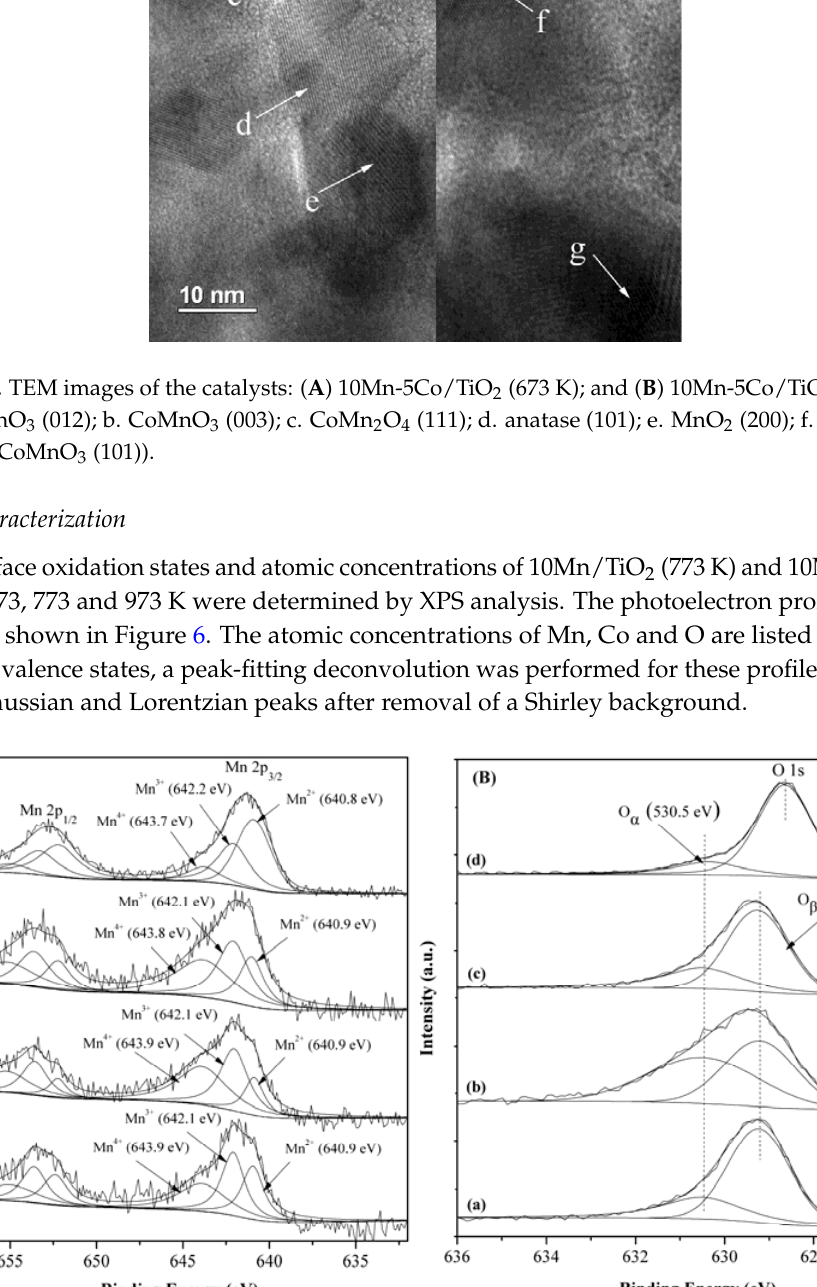
Figure 6. XPS spectra for ( A ) Mn 2p and ( B ) O 1s of the catalysts: ( a ) 10Mn/TiO 2 (773 K); ( b ) 10Mn ‐ 5Co/TiO 2 (673 K); ( c ) 10Mn ‐ 5Co/TiO 2 (773 K); and ( d ) 10Mn ‐ 5Co/TiO 2 (973 K).